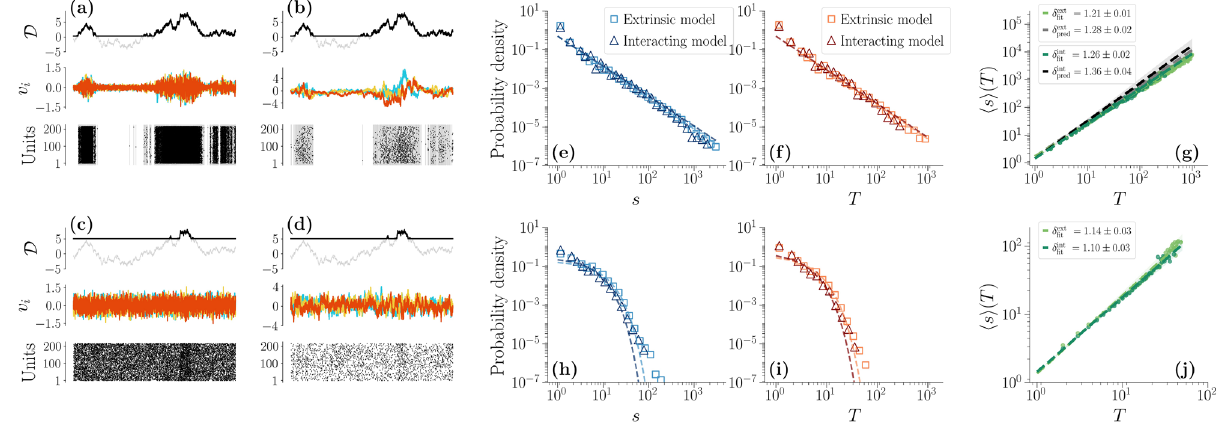
0.3 ( a – b , e – g ) and at D 5 (c-d,h-j), with ∗ = = ext 1.60 0.01 , τ int 1.55 0.01 = ± = ±